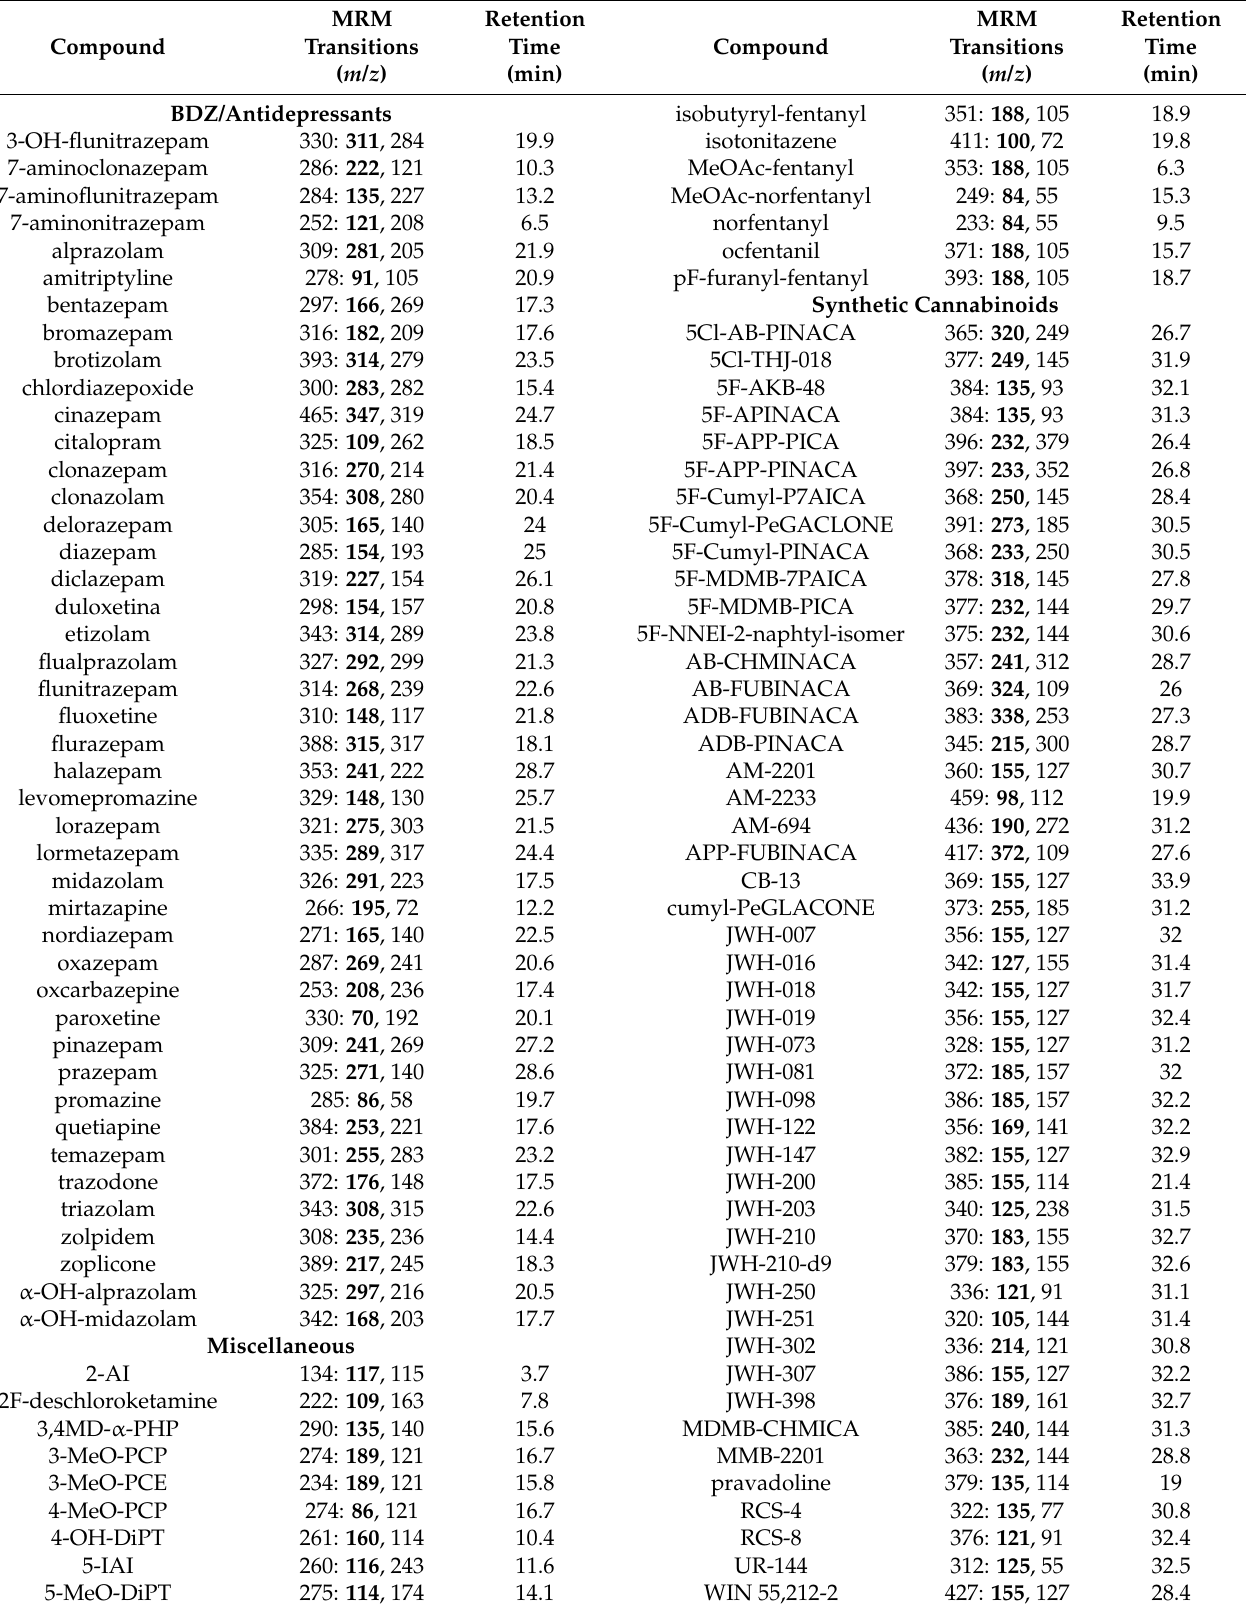
Table 1. MRM transitions of each compound included in the screening method. Quantitative transitions are shown in bold.